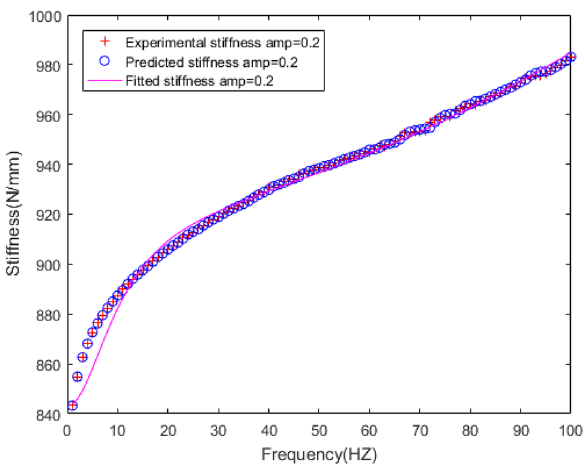
Figure 19. Fitting the curve of dynamic stiffness with five-parameter mathematical model under amplitude 0.2